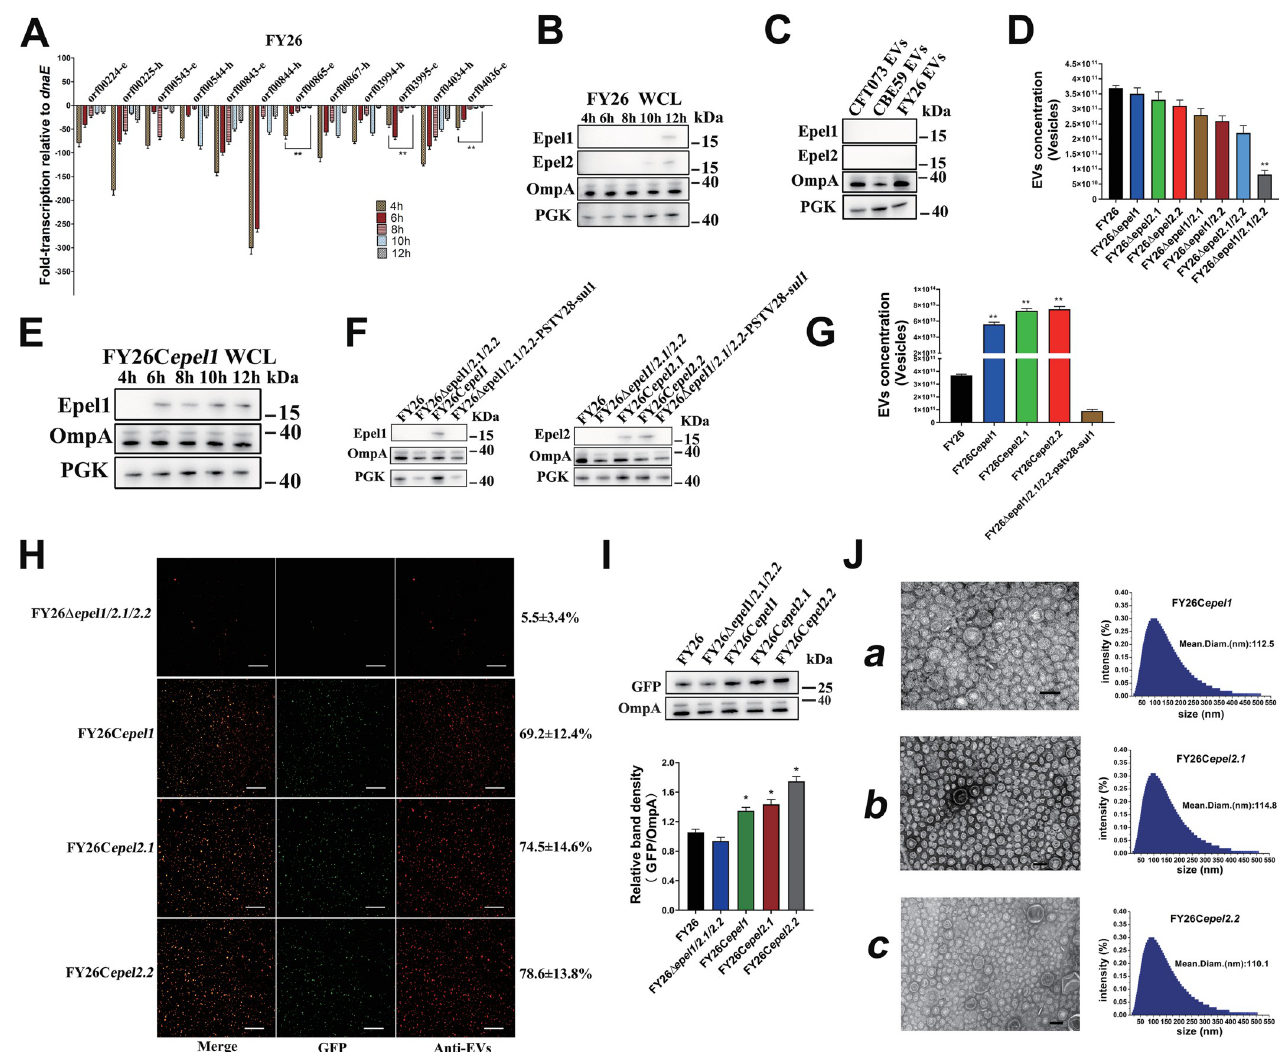
Fig 7. Prophage endolysins induce the formation of ExPEC cytoplasm-carrying vesicles. (A) Transcription levels of endolysin genes in ExPEC strains in different growth phases (4, 6, 8, 10, and 12 h) were determined with RT–qPCR.–h, putative holin genes; -e, putative endolysin genes. Data shown are the means ± SEM of three independent experiments relative to the housekeeping gene dnaE . Statistical significance was evaluated with one-way ANOVA ( �� P < 0.01). (B) Protein levels of endolysins (Epel1 and Epel2 variants) in whole-cell lysates of ExPEC strains were determined with western blotting. (C) Protein levels of endolysins (Epel1 and Epel2 variants) in EVs of ExPEC strains (CBE59, FY26 and CFT073) at 12 h were determined with western blotting. (D) The concentrations of purified EVs produced by several mutants were determined with a nanoparticle tracking analysis (NTA). (E) Protein levels of Epel1 in complemented strains were determined with western blotting. (F) Protein levels of Epel1 and the Epel2 variants in the EVs produced by the complemented strains at 12 h were determined with western blotting. (G) The concentrations of purified EVs produced by FY26C epel1 , FY26C epel2 . 1 , and FY26C epel2 . 2 were determined with NTA. (H) Immunofluorescent detection of EVs produced by several mutants and complemented strains. (I) GFP and OmpA proteins in EVs were determined with western blotting. (J) The EVs produced by FY26C epel1 , FY26C epel2 . 1 , and FY26C epel2 . 2 were observed with transmission electron microscopy (TEM). The size distributions of the three purified EVs were detected with Dynamic light scattering (DLS). Scale bars: 200